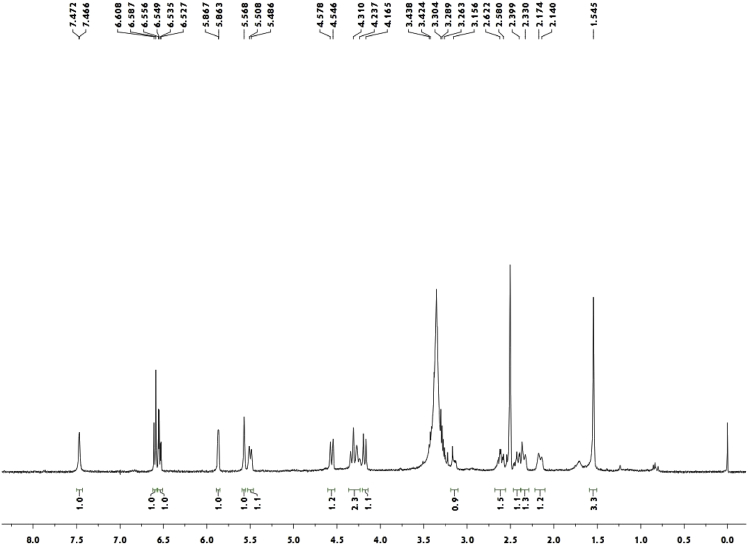
1H-NMR spectrum of meroterpenoid 2.